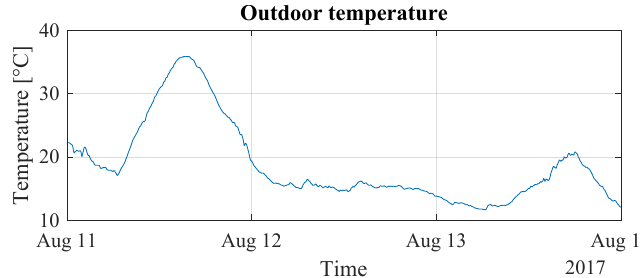
Figure 14. Outdoor temperature on 11–13 August